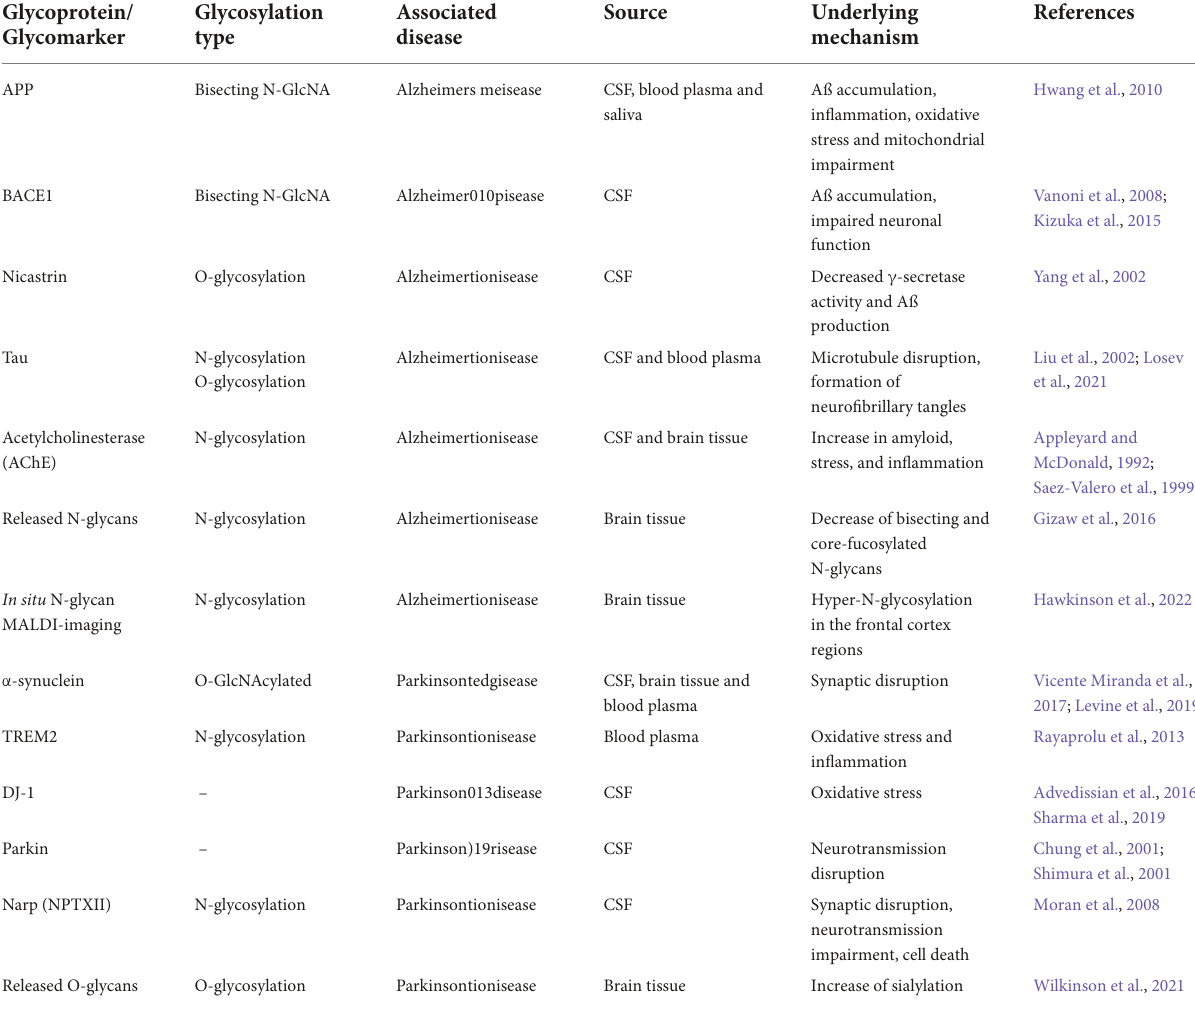
TABLE 1 Summary of glycoproteins, corresponding pathologies resulting from glycosylation modifications, and their suggested underlying